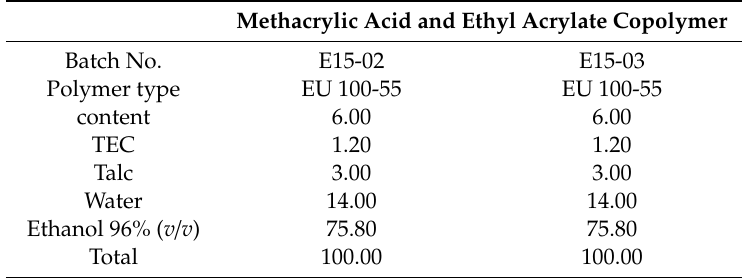
Table 4. Composition of Eudragit ® coating dispersion. All concentrations are given in percent ( w / w ). Methacrylic Acid and Ethyl Acrylate Copolymer Batch No.